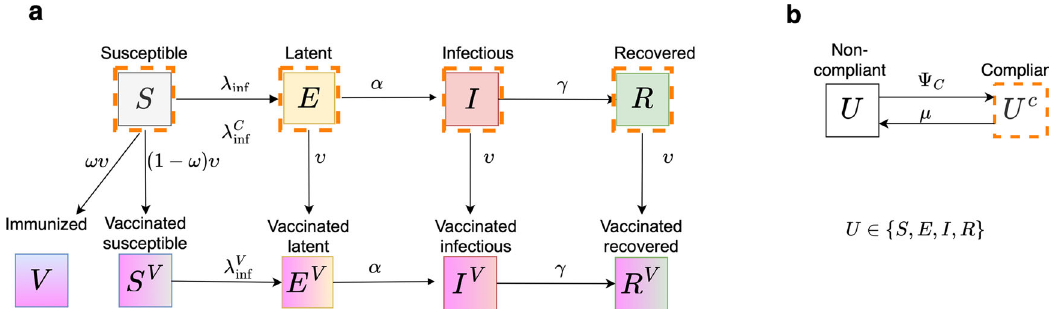
Fig. 1 Flow diagram of the infection transmission dynamics coupled with compliance and vaccination processes. a Flow diagram of infection transmission and vaccination rollout, b Flow diagram of acquisition and loss of compliance. Solid-coloured rectangles denote non-vaccinated compartments; solid-bordered rectangles denote non-compliant compartments; orange dashed-bordered rectangles denote compliant compartments; gradient-coloured rectangles denote vaccinated compartments. Susceptible individuals ( S , S C , and S V ) become exposed ( E , E C , and E V , respectively) with rates λ inf , λ C inf, and λ V inf through contact with infectious individuals ( I , I C , and I V ). Exposed individuals become infectious ( I , I C , and I V , respectively) at rate α . Infectious individuals recover ( R , R C , and R V ) at rate γ . Compliance is gained with rate Ψ C and lost with rate μ . Individuals in any state of infection or compliance can get vaccinated. A proportion ω of susceptible individuals S , who were vaccinated are fully protected, V . Individuals who were vaccinated, but did not obtain protection, are denoted by S V , E V , I V and R V and are epidemiologically indistinguishable from their non-vaccinated